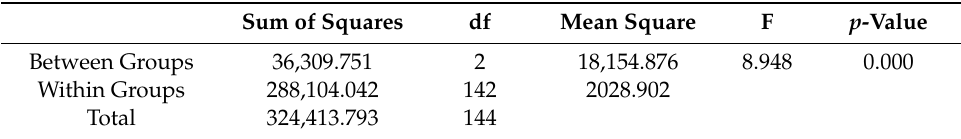
Table 11. ANOVA cognitive maps analyses in the three investigated selected points. Sum of Squares df Mean Square F p -Value Between Groups 36,309.751 2 18,154.876 8.948 0.000 Within Groups 288,104.042 142 2028.902 Total 324,413.793 144